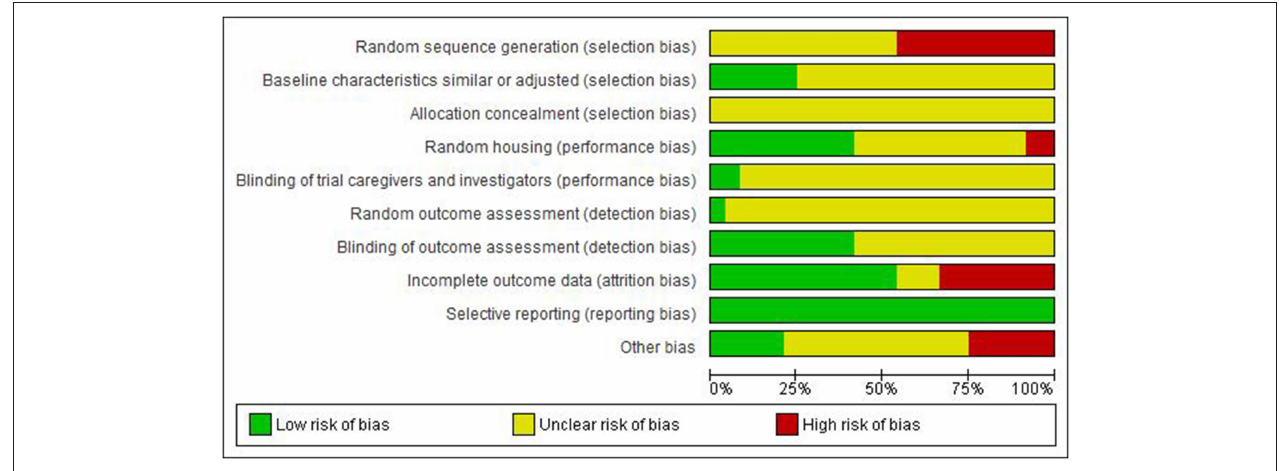
FIGURE 4 | Risk of bias across pre-clinical